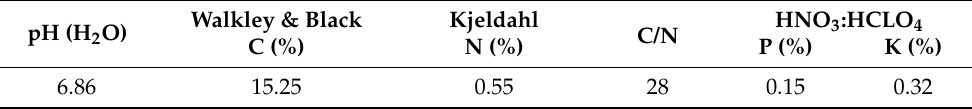
Table 3. Analysis of nutrient content of compost fertilizer.